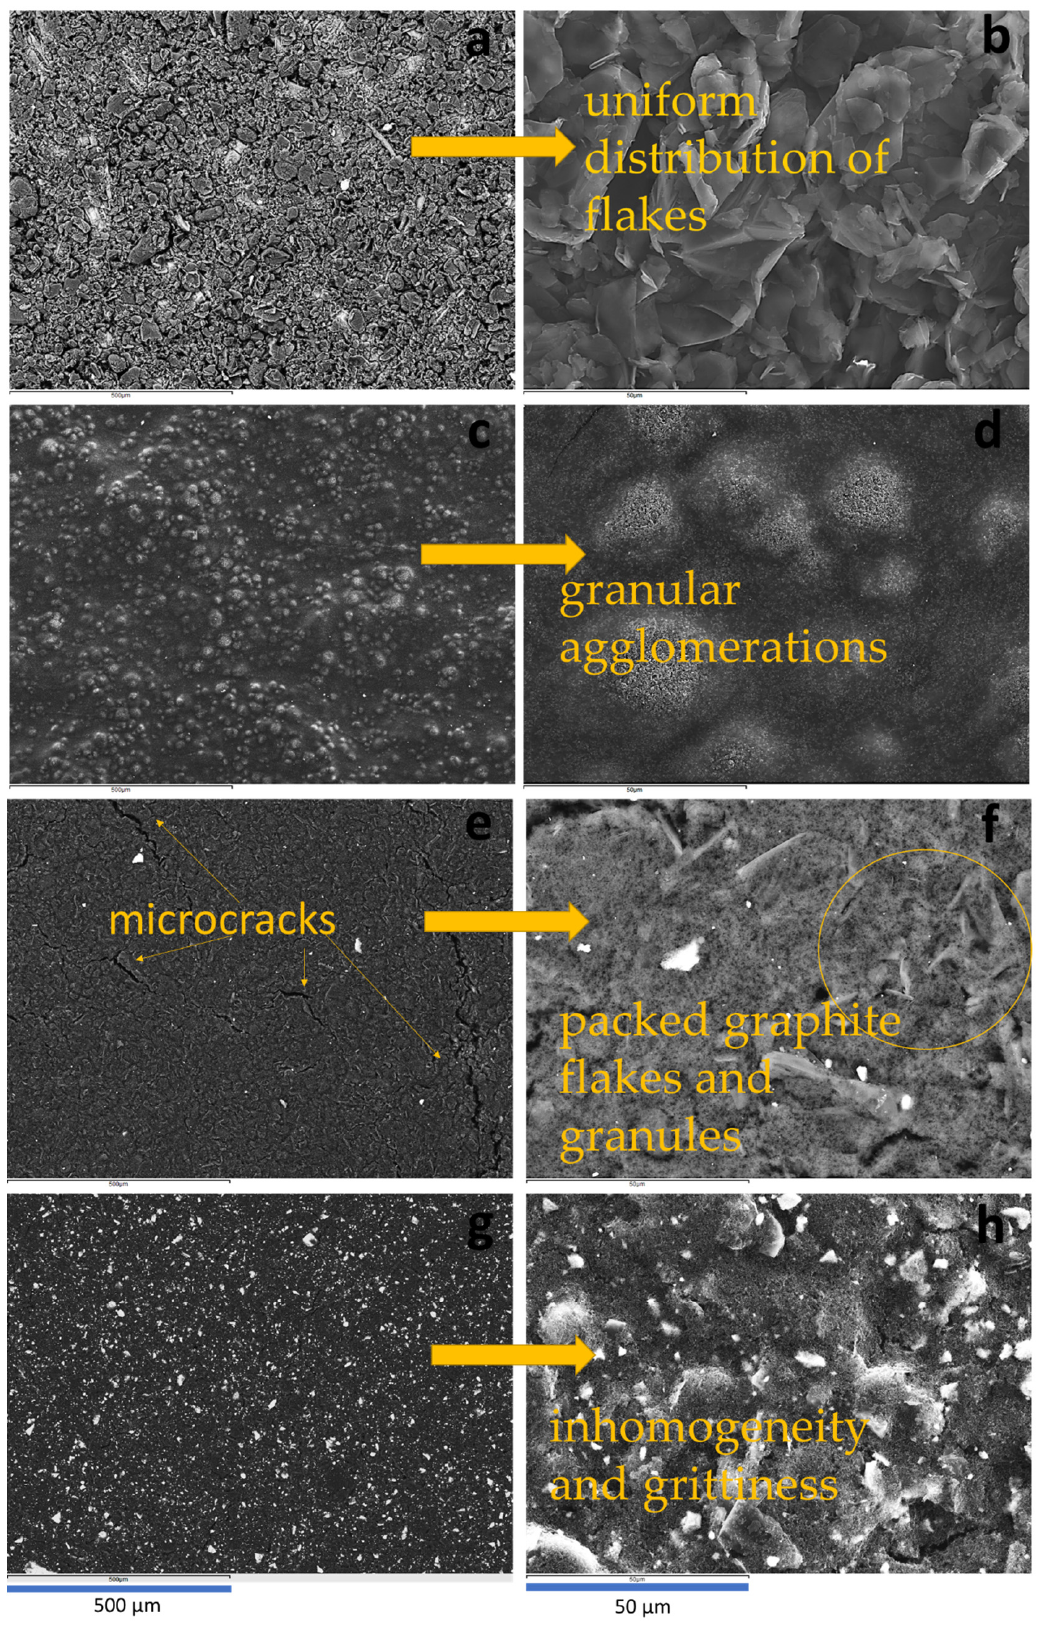
Figure 1. SEM images of the composite films at different magnification (listed in Table 2): ( a , b ) Sample #1, ( c , d ) Sample #2, ( e , f ) Sample #3, ( g , h ) Sample #5.